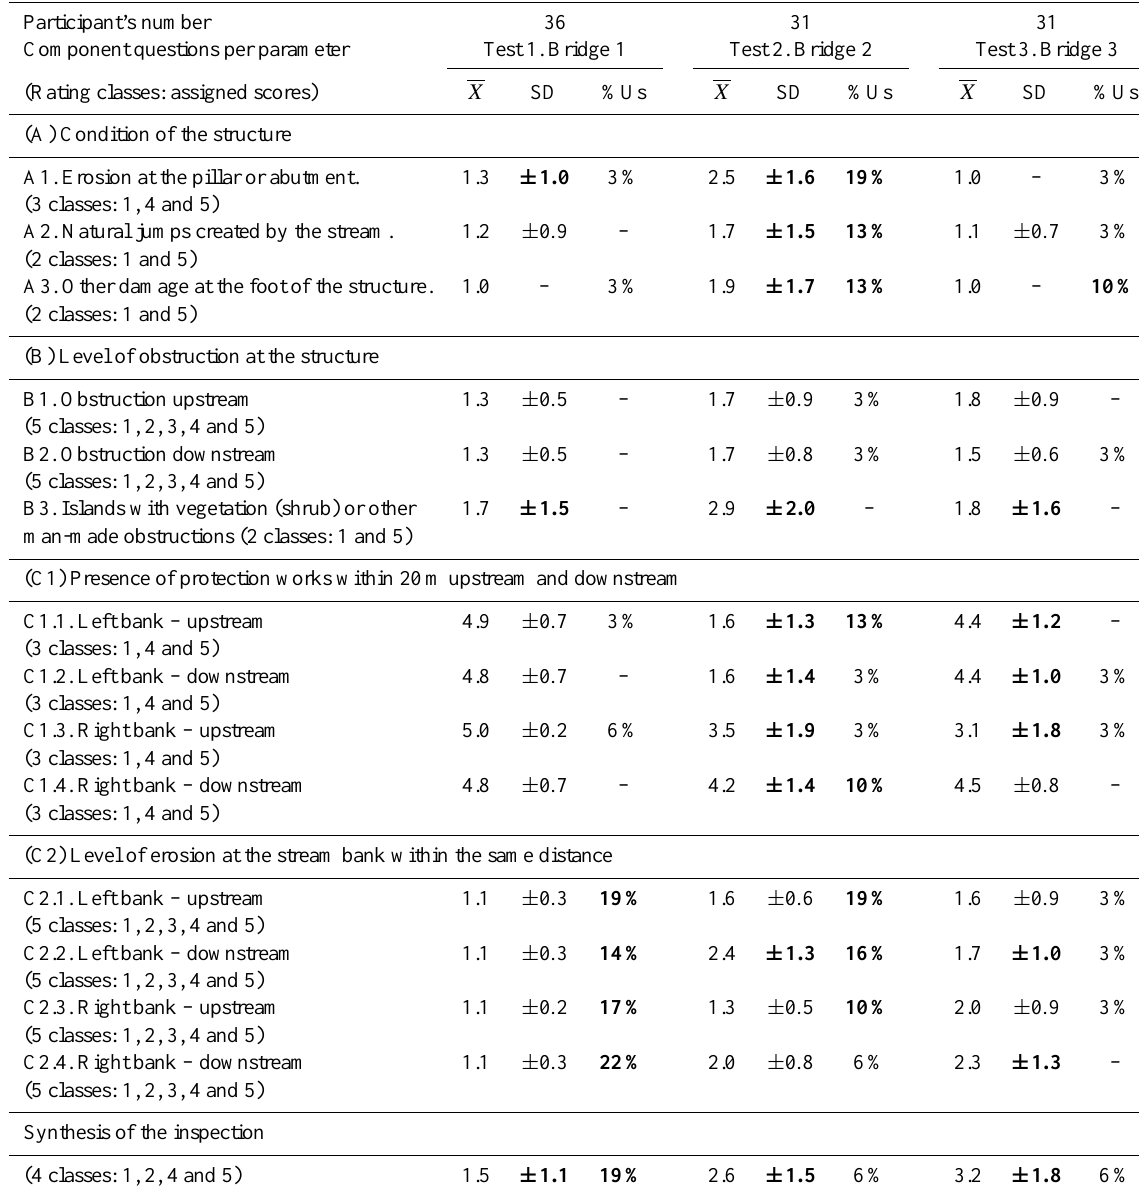
Table 5. Evaluation of scores for the data collected in the inspection tests for bridges. The values in bold distinguish the lowest performance. Participant’s number 36 31 31 Component questions per parameter Test 1. Bridge 1 Test 2. Bridge 2 Test 3. Bridge